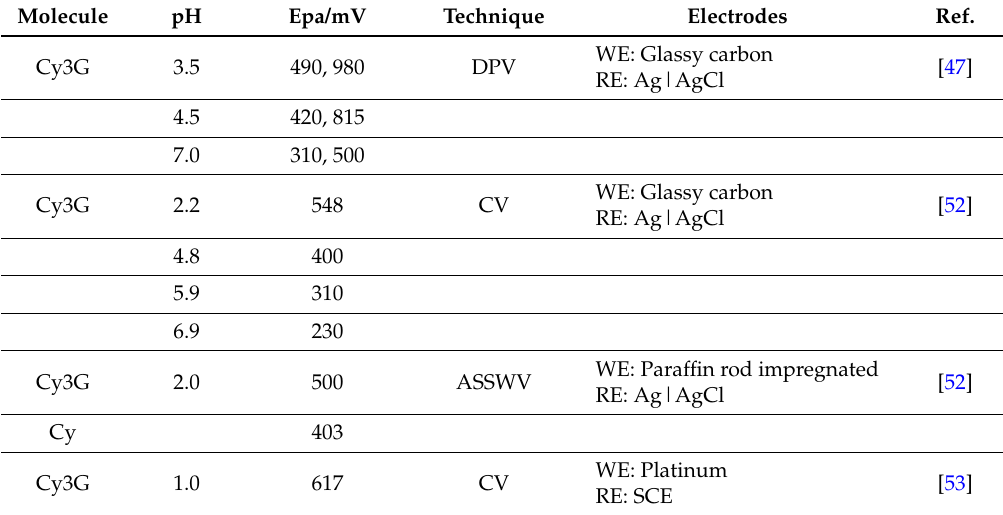
Table 2. Voltammetric oxidation of and Cy3G and its aglycone 1